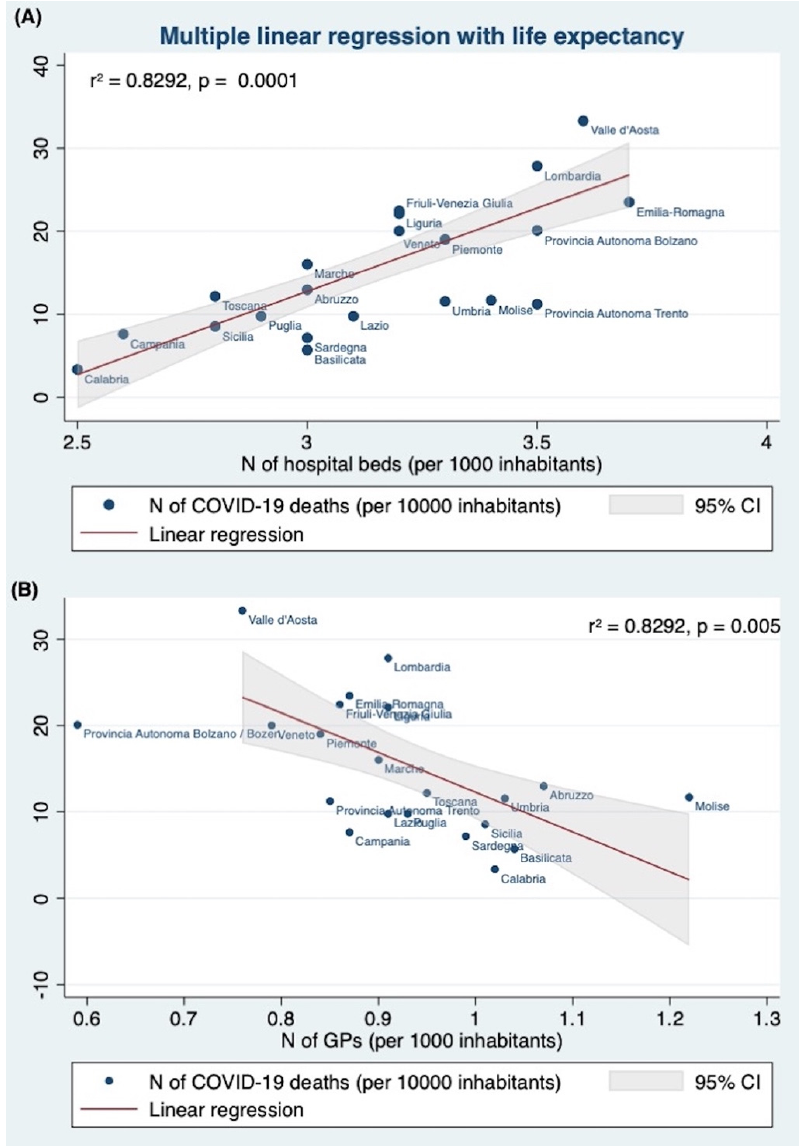
Figure 2. Multiple linear regression among the number of COVID-19 deaths ( × 10,000 inhabitants) and ( A ) the number of hospital beds ( × 1000 inhabitants), and ( B ) the number of GPs ( × 1000 inhabitants) per Italian region. In a multivariate linear regression analysis, introducing the number of COVID-19 deaths (per 100,000) as the dependent variable and the life expectancy, the number of hospital beds (per 1000), the health expenditure per capita, the GPs per 1000, and the number of LTCF significantly as the independent variable, the number of hospital beds (per 1000) ( β = 15.4037, p = 0.004) and the number of GPs (per 1000 inhabitants) ( β = − 32.4074, p = 0.005) significantly predicted the number of COVID-19 deaths ( × 10,000 inhabitants). The Italian regions with a higher number of hospital beds ( × 1000 inhabitants) and a lower number of GPs showed a higher COVID-19 death rate. The line shows the linear regression value obtained by the multivariate